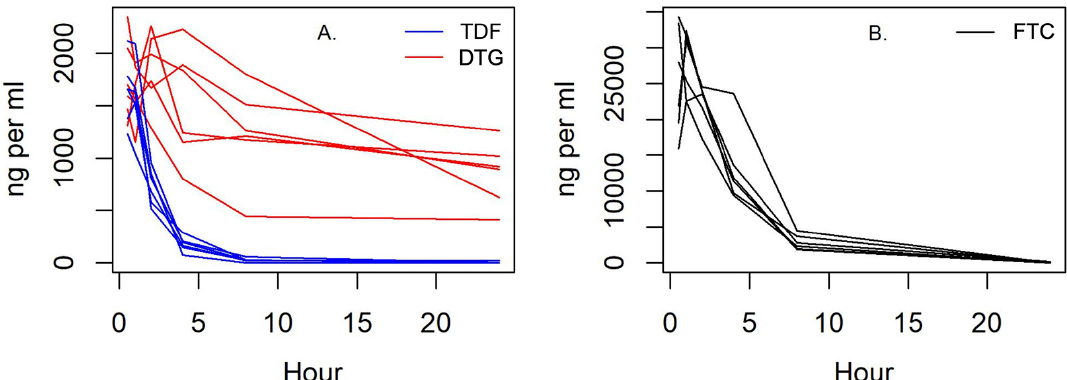
Figure 6. Dolutegravir (A) plasma concentration remained stable for 24 h. ( A ) Tenofovir (TDF) and ( B ) emtricitabine (FTC) plasma concentrations quickly declined in cats and remained low by 4 and 8 h after administration,